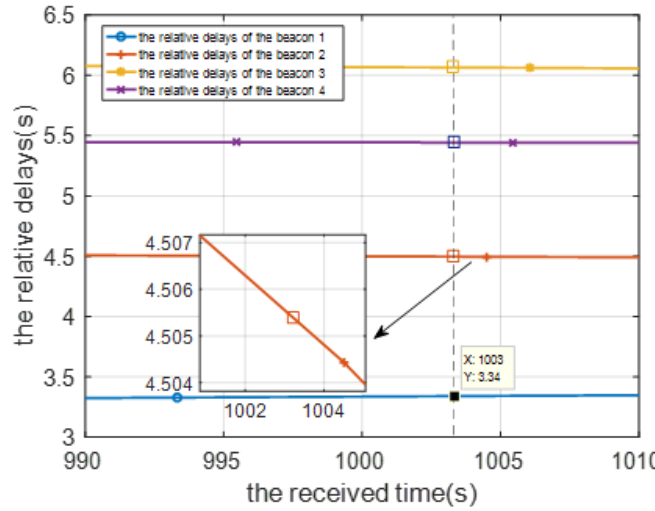
Figure 8. Relative time delay result of the location signal. Figure 9. Relative propagation delay after motion compensation.